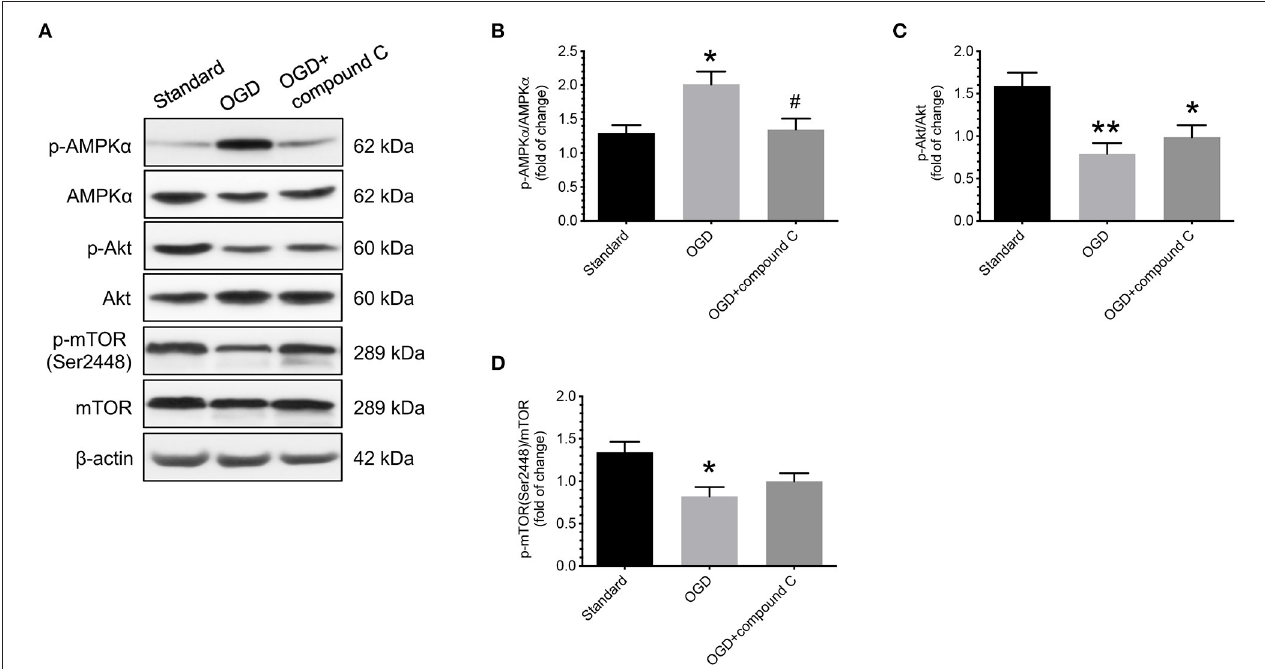
FIGURE 5 | Effects of compound C on phosphorylation levels of Akt and mTOR in human cytotrophoblast cells under OGD conditions. Under OGD condition, administering compound C, a specific inhibitor of AMPK, did not cause a significant difference in the phosphorylation levels of Akt compared to the vehicle control. There was an increase in mTOR phosphorylation levels, though not statistically significant, when compound C was administered, as compared to the vehicle controls. (A) Representative blots show the levels of phosphorylated and total forms of AMPK α , Akt, and mTOR. β -actin was used to normalize loading variability. (B–D) Data are presented as mean ± SEM; n = 9 for each group. *, P < 0.05; **, P < 0.01, compared to cells cultured at standard conditions; # , P < 0.05, compared with vehicle controls; based on one-way analysis of variance followed by Tukey’s post-hoc test. Standard, standard culture conditions; OGD, vehicle controls under oxygen-glucose